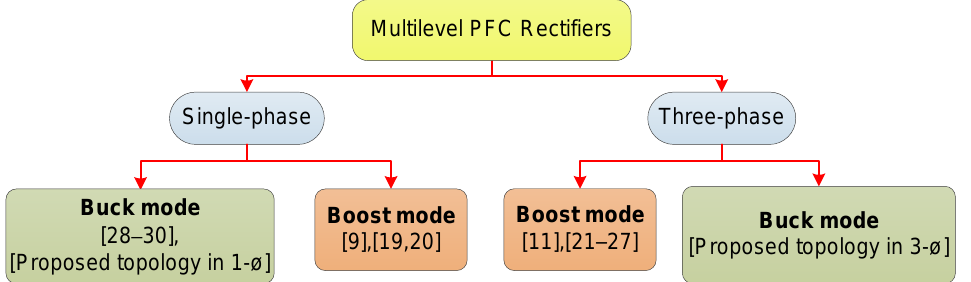
Figure 3. Classification of multilevel PFC rectifiers [9,11,19–30]. A boosted output voltage is obtained by using conventional MLR topologies such as cascaded H-bridge (single-phase), neutral point clamped and flying capacitors (single and three-phase) [9,19,20]. Other emerging topologies of three-phase multilevel PFC rectifiers [11,21–27] also operate in boost mode. When applied to the EV charging interface, the main challenges posed by MLRs are: (i) conventional MLRs operate as boost rectifiers; MLR topologies require complex methodologies for voltage